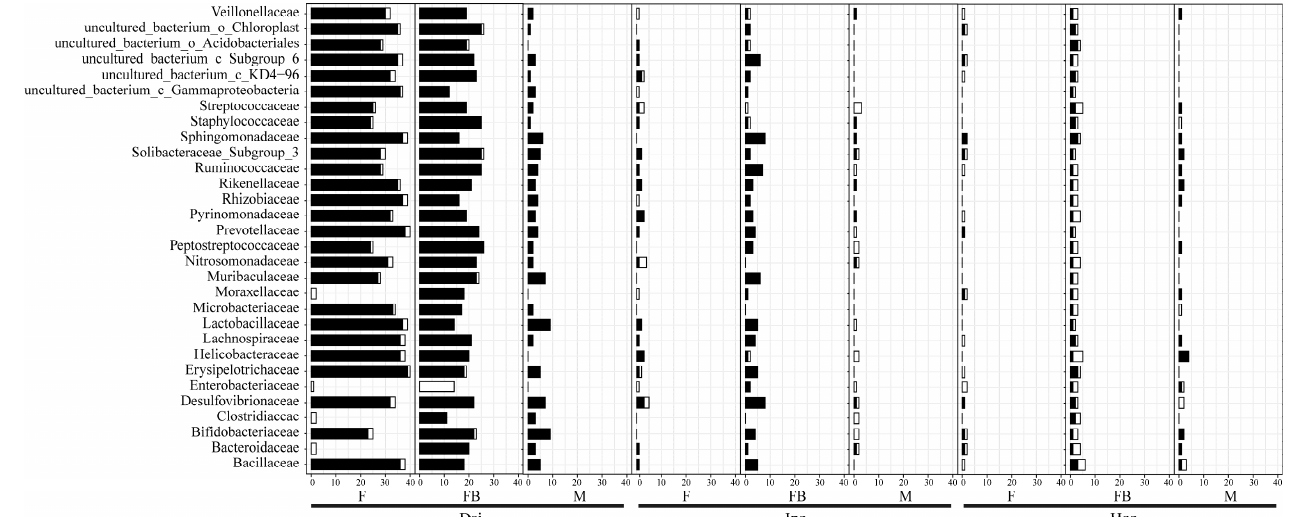
Figure 4. Microbial interactions within ticks. The top 30 bacterial families are included in the chart. White represents co-exclusion/negative correlation, black represents co-occurrence/positive correlation interactions. Notes: F, female; FB, full of blood (engorged); M, male; Dsi, Dermacentor silvarum ; Ipe, Ixodes spersulcatus ; Hco, Haemaphysalis concinna